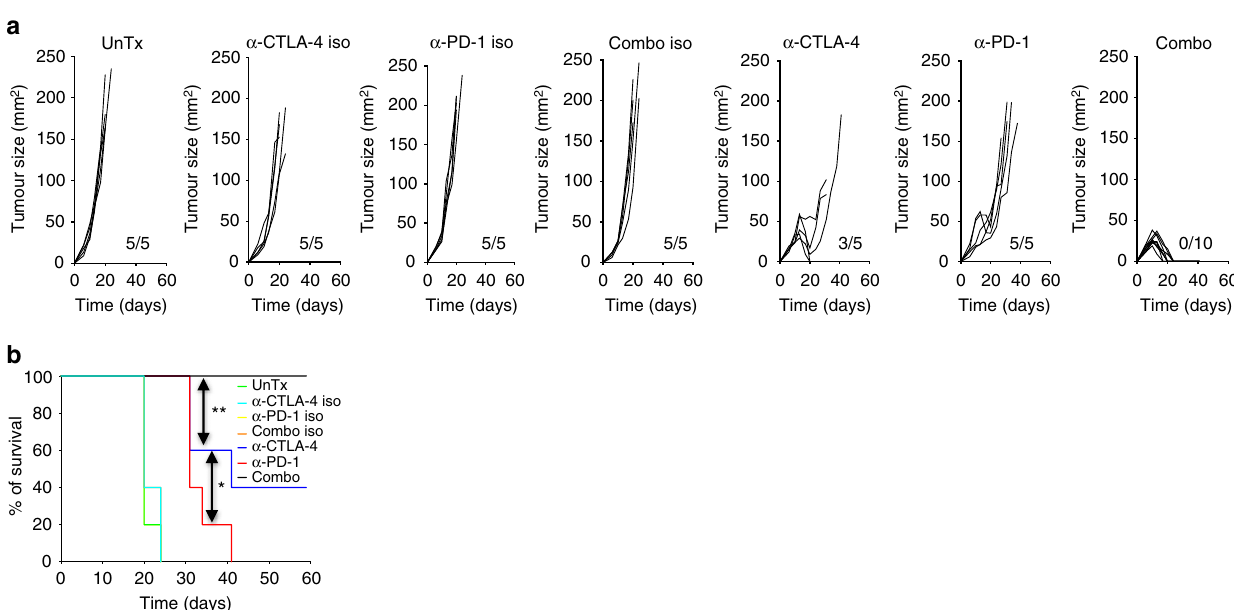
Figure 2 | Combined PD-1 and CTLA-4 blockade eradicates MB49 bladder tumours in mice. Mice bearing 6 days palpable MB49 tumour were left untreated (UnTx) or treated with a -CTLA-4, a -PD-1 or combination of both (Combo) or their corresponding isotype controls ( a -CTLA-4 iso, a -PD-1 iso or Combo iso). ( a ) Individual tumour growth. Tumour size is presented as length (cid:2) width (mm 2 ) and ratios of tumour-growing mice in each groups are shown as insets on each panel. ( b ) Survival curves from one representative experiment are shown. Data are representative of three independent